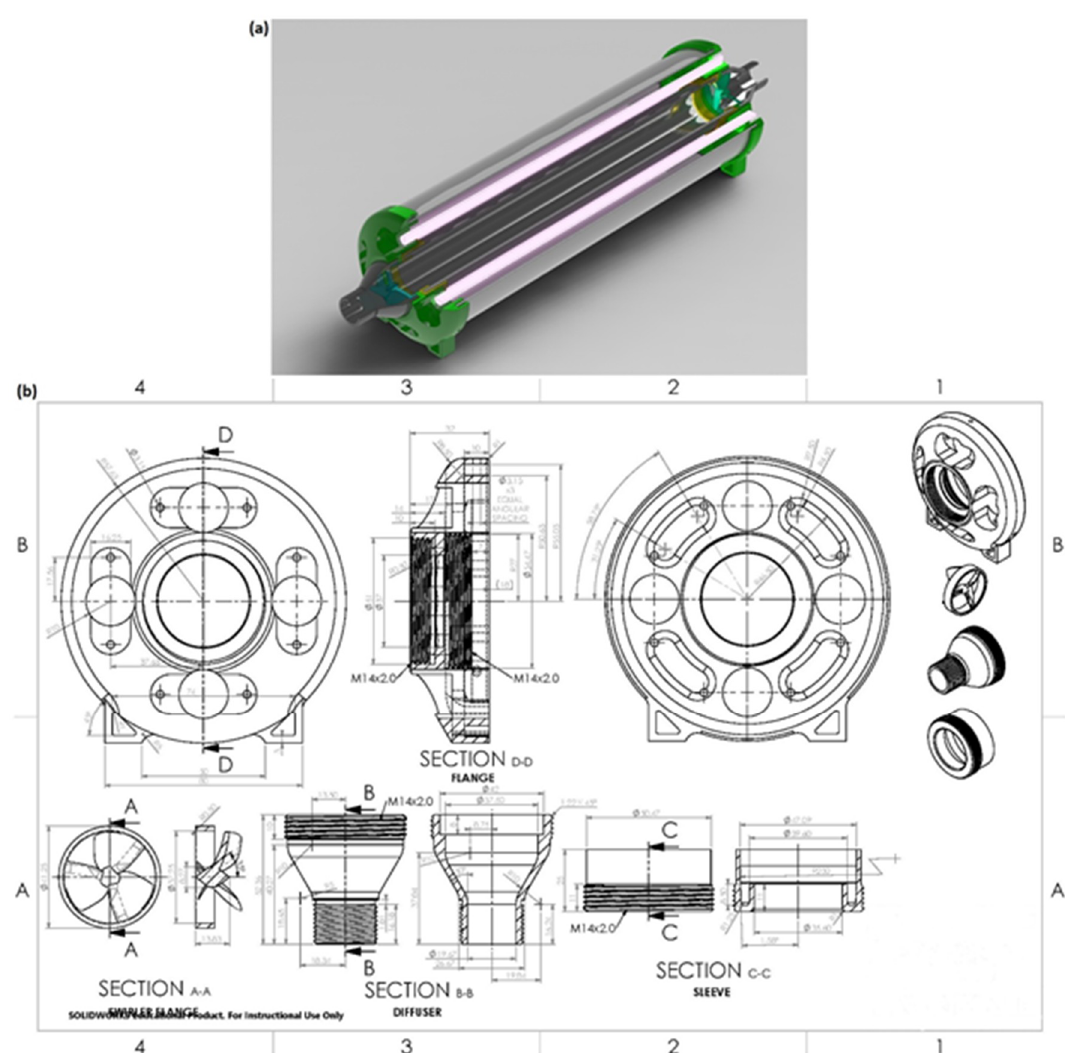
Figure 1. A rendered representation of the UV reactor ( a ) and the design details and dimensions of the various components ( b ).